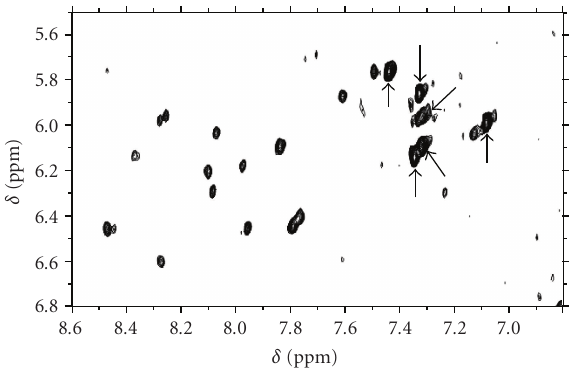
Figure 3: NOESY spectra of d < pGGGTTAGGGTTA > in D 2 O (200ms mixing time) at 600 μ M oligonucleotide concentration (same bu ff er conditions as in Figure 1). Strong H1 (cid:3) -H8 cross-peaks, characteristic of syn guanines, are indicated.